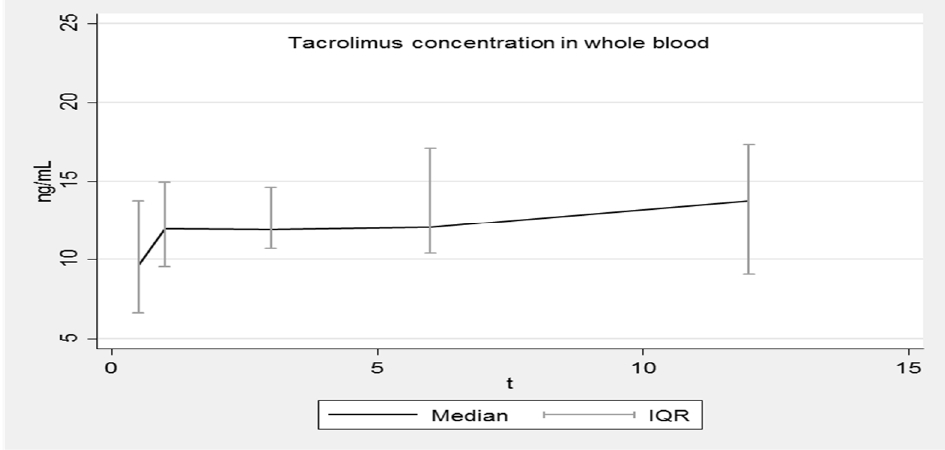
Figure 4. Median concentration–time profile of TAC in whole blood. IQR: interquartile range.